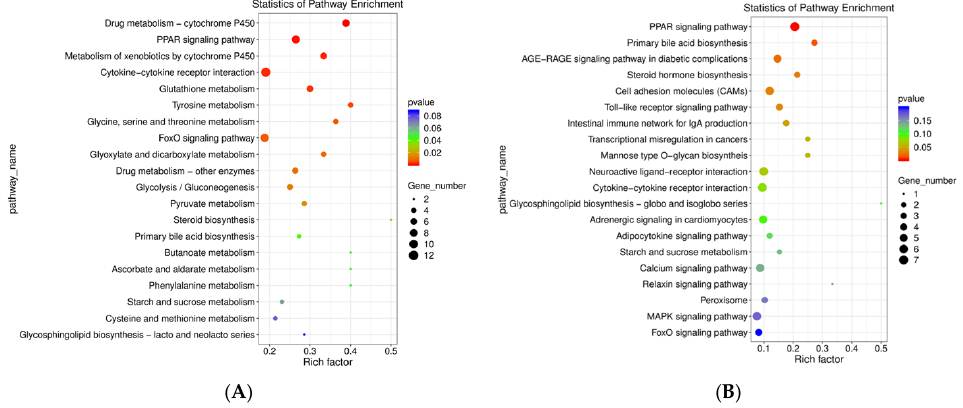
(ko00260), FoxO signaling (ko03320), glyoxylate and dicarboxylate metabolism (ko00630),